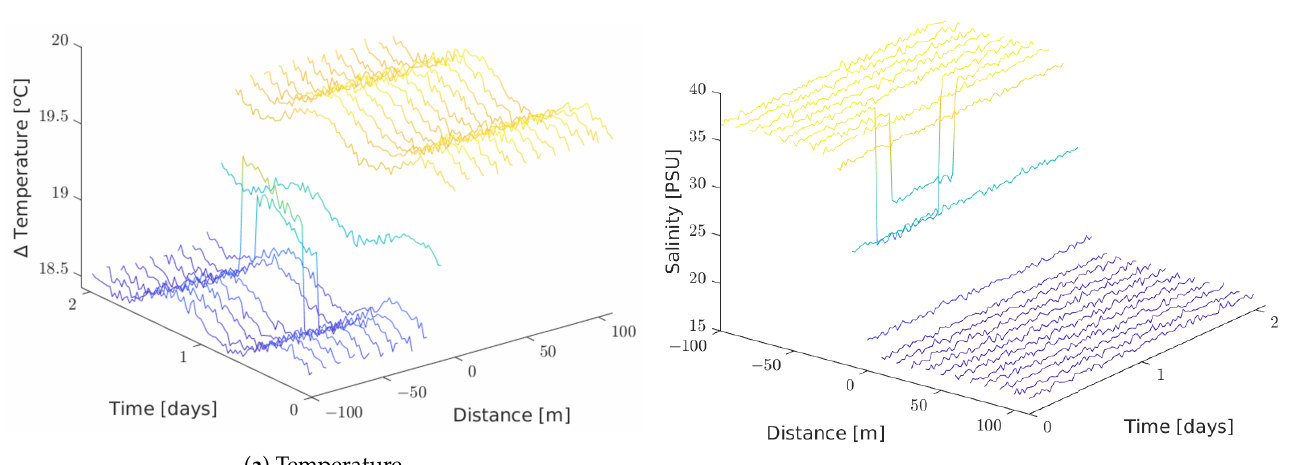
Figure 10. Soft setting.